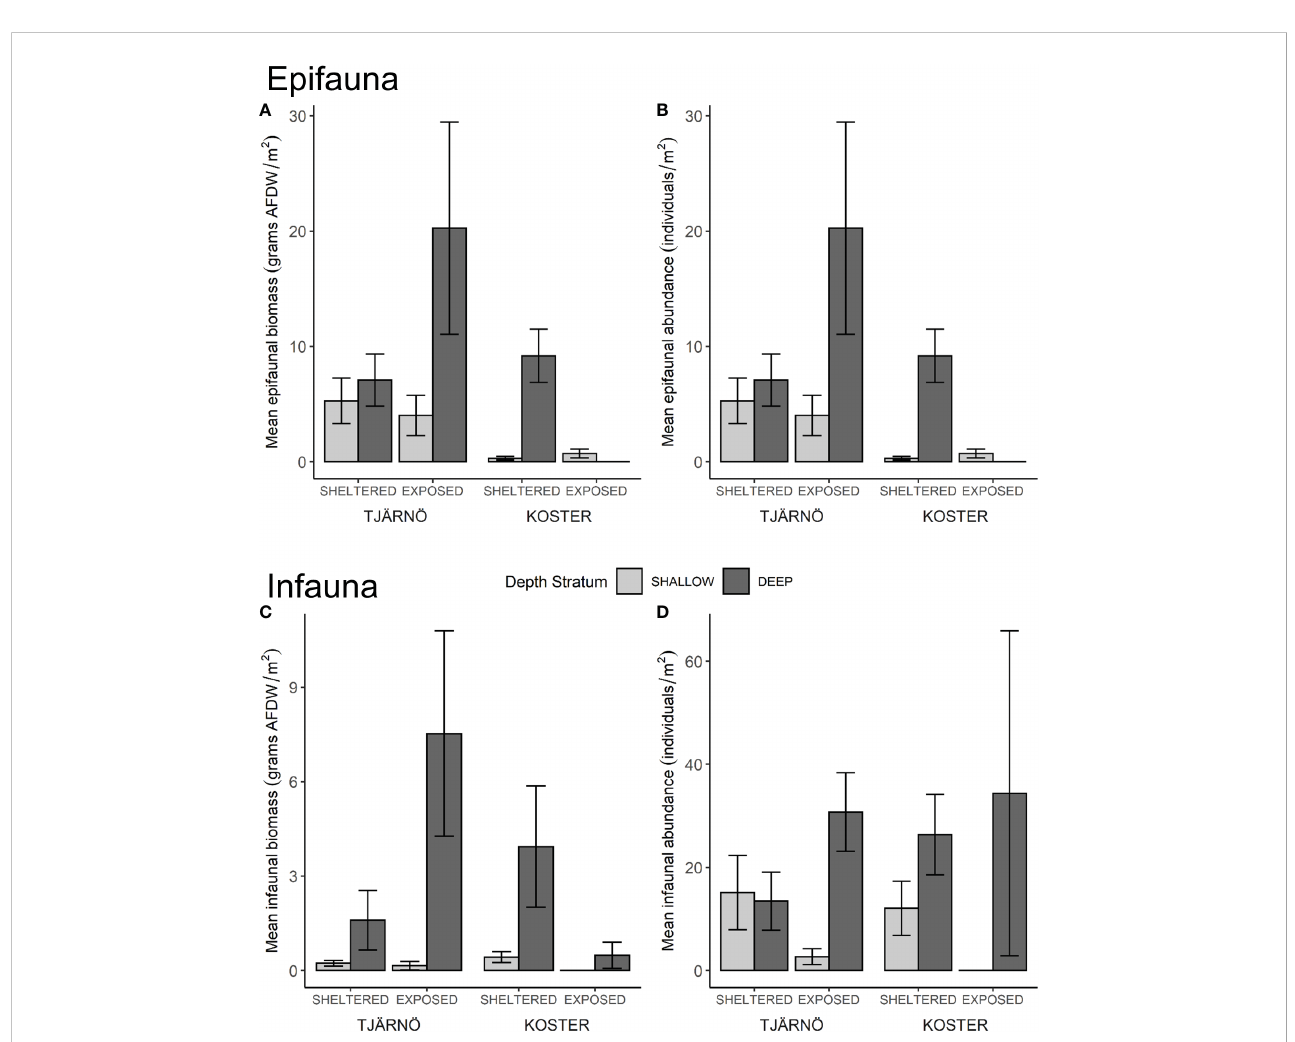
FIGURE 4 Average biomass (AFDW g (cid:129) m-2, A, C ) and abundance (# (cid:129) m-2, B, D ) of epifauna (top) and infauna (lower)(mean ± SE). Note the different scales on the response axes between epi- and infauna.